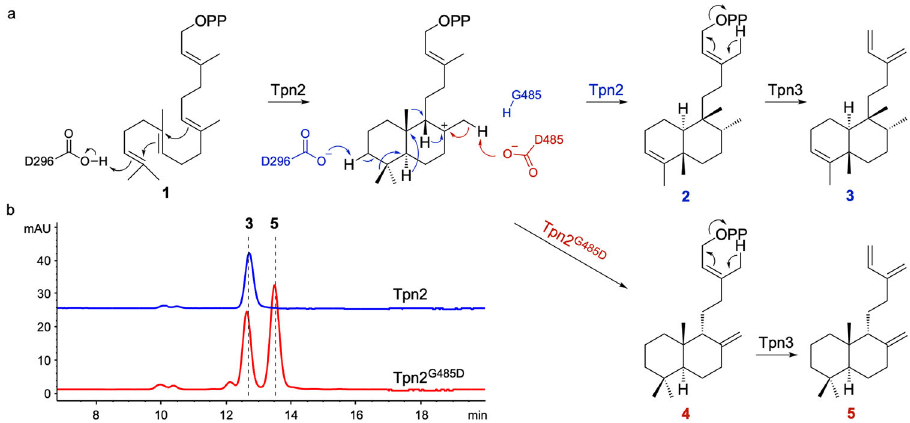
Fig. 3 G485 is a single residue switch controlling labdane and clerodane formation in Tpn2. a Cyclization mechanism of Tpn2 (blue) and Tpn2 G485D (red). b HPLC analysis of Tpn2-Tpn3 and Tpn2 G485D -Tpn3 fusion proteins in the E. coli MKI4